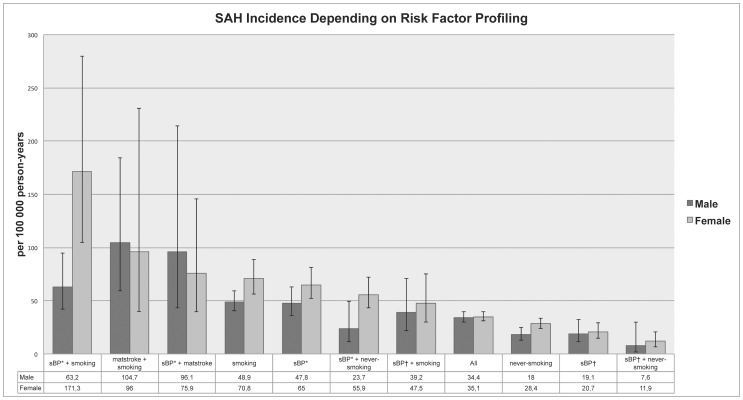
Crude SAH incidences in 25-year-old and older people on the basis of risk factor profiling.Error bars represent 95% confidence intervals. sBP* = systolic blood pressure ≥159 mmHg. sBP† = systolic blood pressure ≤122 mmHg. smoking = current smoking. matstroke = history of premature stroke (any kind) in mother.